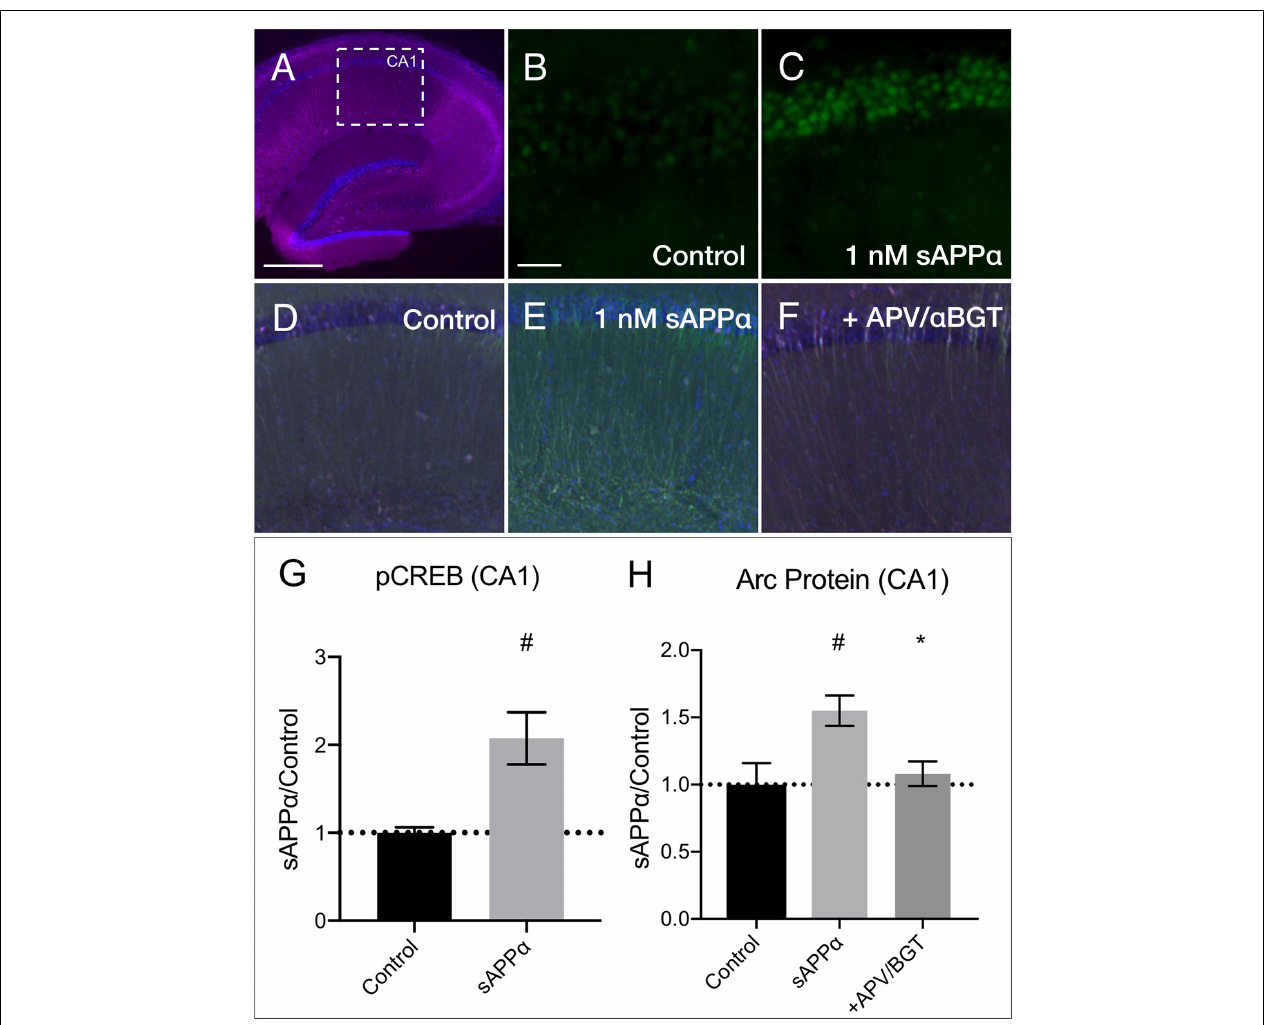
FIGURE 9 | sAPP α increases in CREB phosphorylation and Arc protein in acute hippocampal slices. (A) A representative transverse section of an acute hippocampal slice, with a subregion of area CA1, used for quantitative analysis, outlined by a white dotted box (neurons: MAP2/magenta; nuclei: DAPI/blue; imaged at 4x magnification; scale bar = (500 µ m). Relative to (B) no drug controls, (C) incubation of slices with sAPP α (1 nM, 15 min, n = 2 rats, 4 slices) increased pCREB ser133 (green; imaged at 20x magnification; scale bar = 100 µ m) in the PCL of CA1. Relative to (D) no drug controls, (E) incubation of slices with sAPP α (1 nM, 2 h, n = 3 rats, 4 slices) significantly increased Arc protein expression (green; imaged at 4x magnification) in area CA1. Co-incubation of sAPP α with (F) APV and α BGT ( n = 3 rats, 4 slices) attenuated this effect. Normality was detected by Shapiro–Wilk normality tests. Data are expressed as mean ± SEM. Significance of pCREB (G) and (H) Arc protein expression was calculated using a students t -test, and one-way ANOVA with Šidák’s multiple comparisons test, respectively. Hashes (#) indicate significance between control and sAPP α -treated; asterisks ( ∗ ) indicate significance between sAPP α - and antagonist-treated; # p ≤ 0.05, ∗ p = 0.04. CA1, cornu ammonis 1; PCL, pyramidal cell